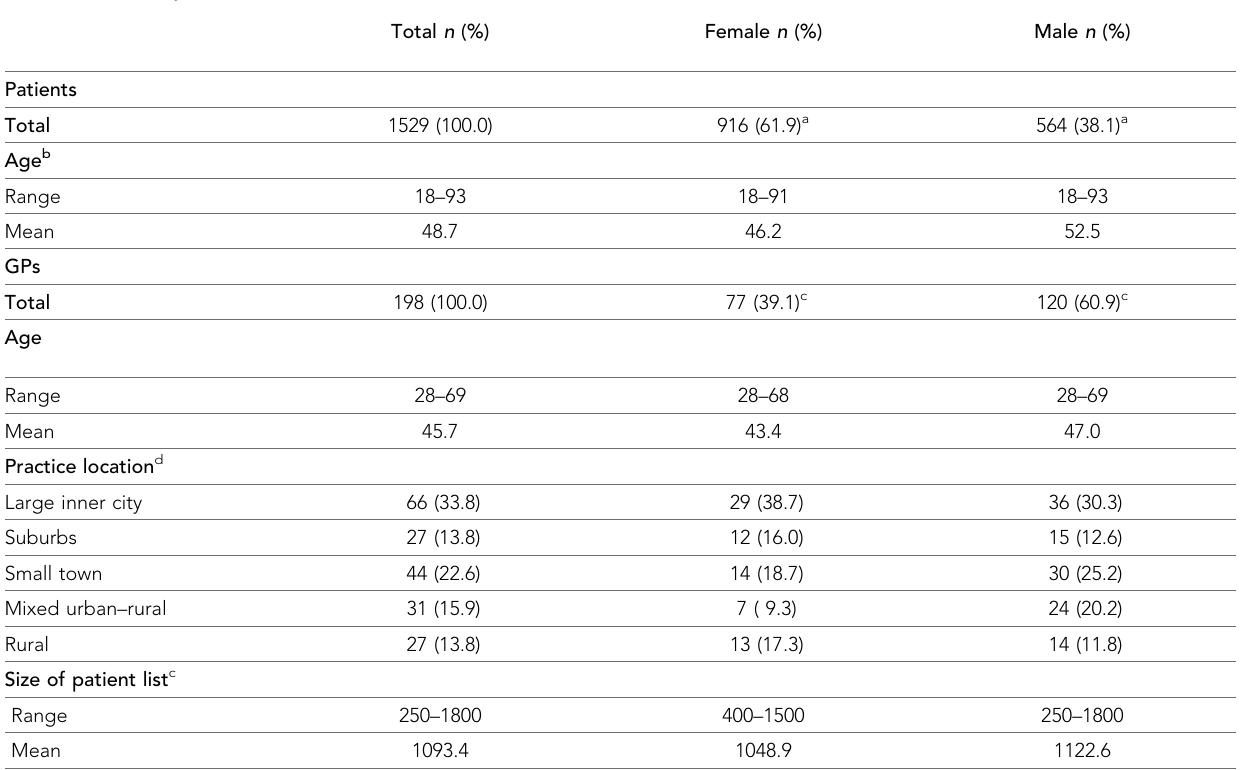
Table 1 Demographics of patients ( n = 1529) and GPs ( n = 198) participating in the Norwegian part of the Quality and Costs of Primary Care in Europe (QUALICOPC) study, 2012–2013.